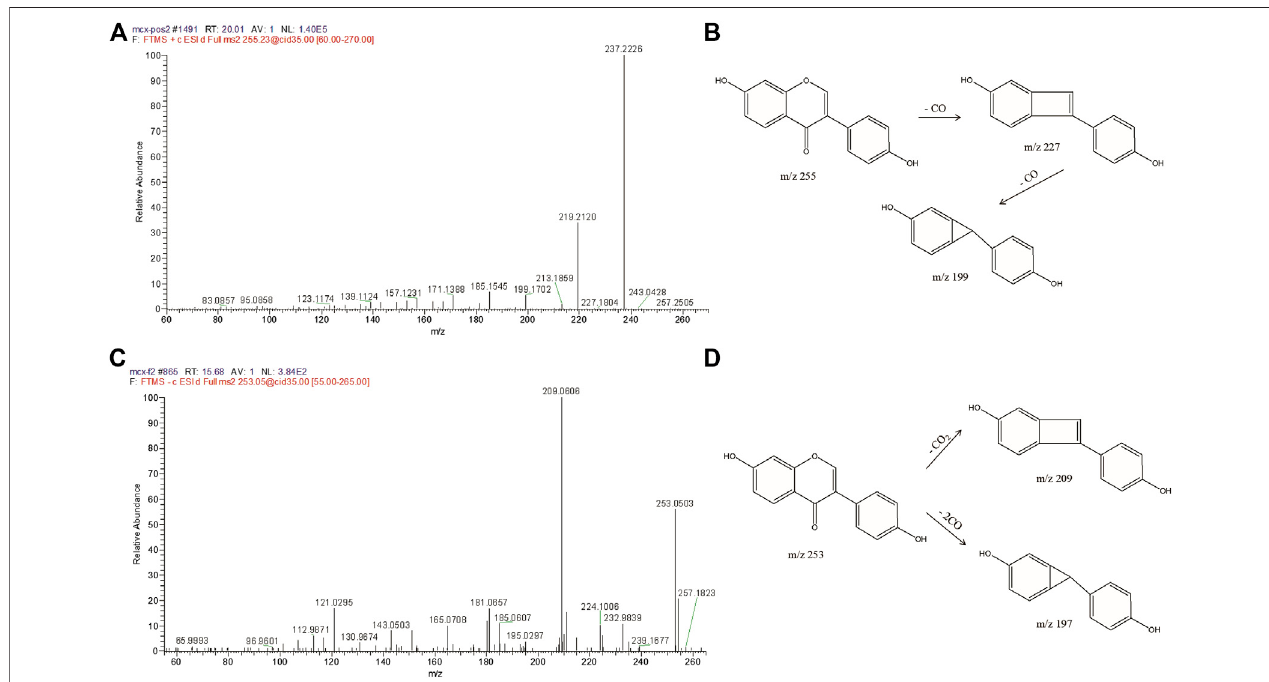
FIGURE5| MS 2 spectrumofFlavonoidsandmainmassspectrometryfragmentationpathways.MS 2 spectrumandfragmentationpathwaysofdaidzeininpositive ion mode (A) (B) . MS 2 spectrum and fragmentation pathways of daidzein in negative ion mode (C) (D)